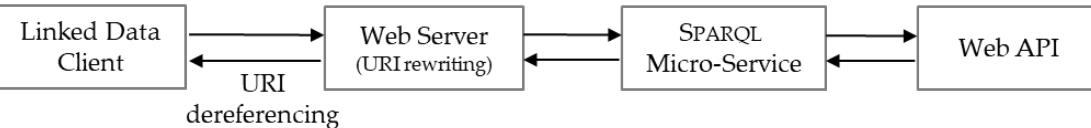
Figure 2. Using a SPARQL micro-service to dereference URIs to RDF